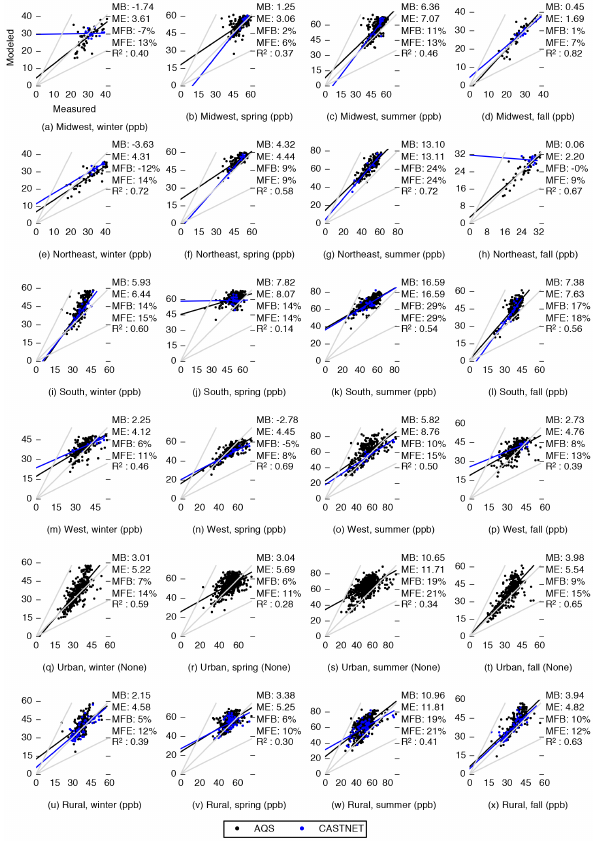
Figure A6. Comparison of modeled and measured annual average O 3 concentrations, disaggregated by region and season.